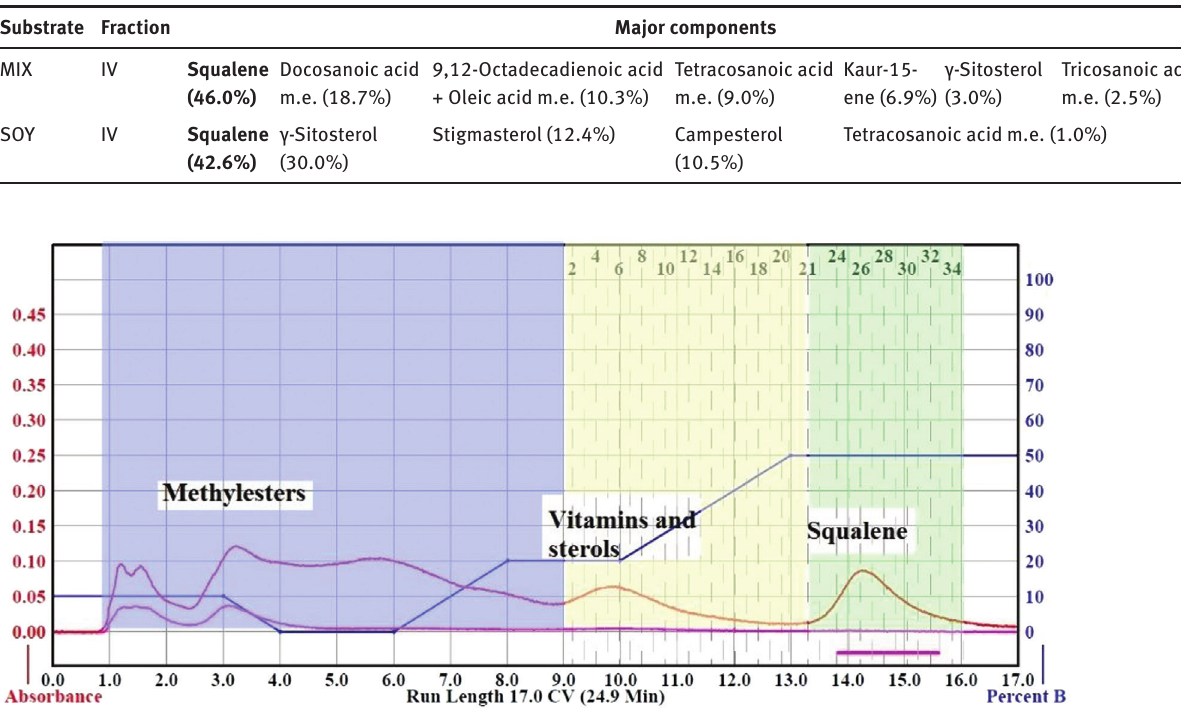
Figure 4: Chromatogram with the 86 g C-18 silica column.